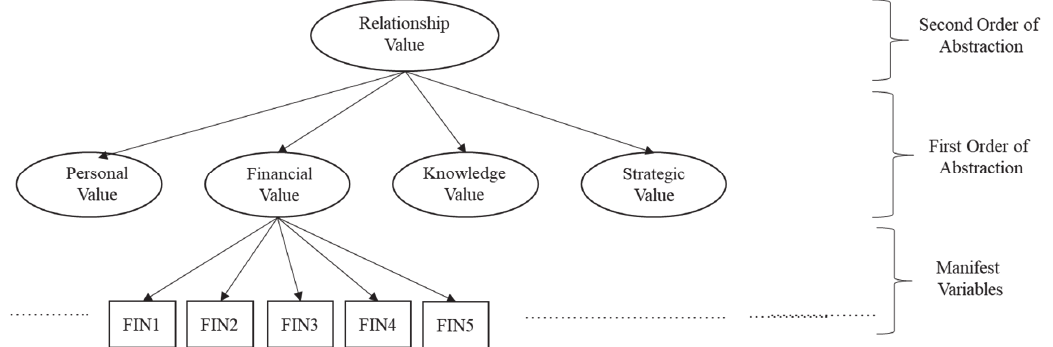
Fig 2. The hierarchy structures of relationship value and